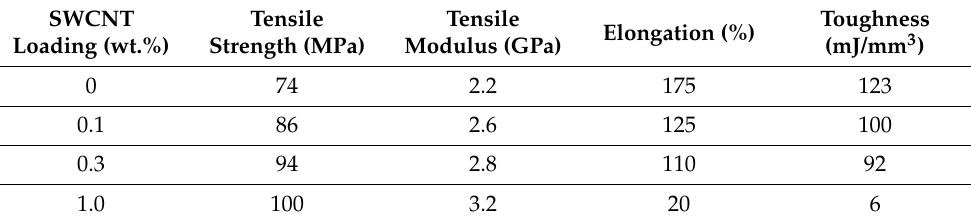
Table 6. Tensile properties of polyimide/SWCNT composites. SWCNT Loading (wt.%)